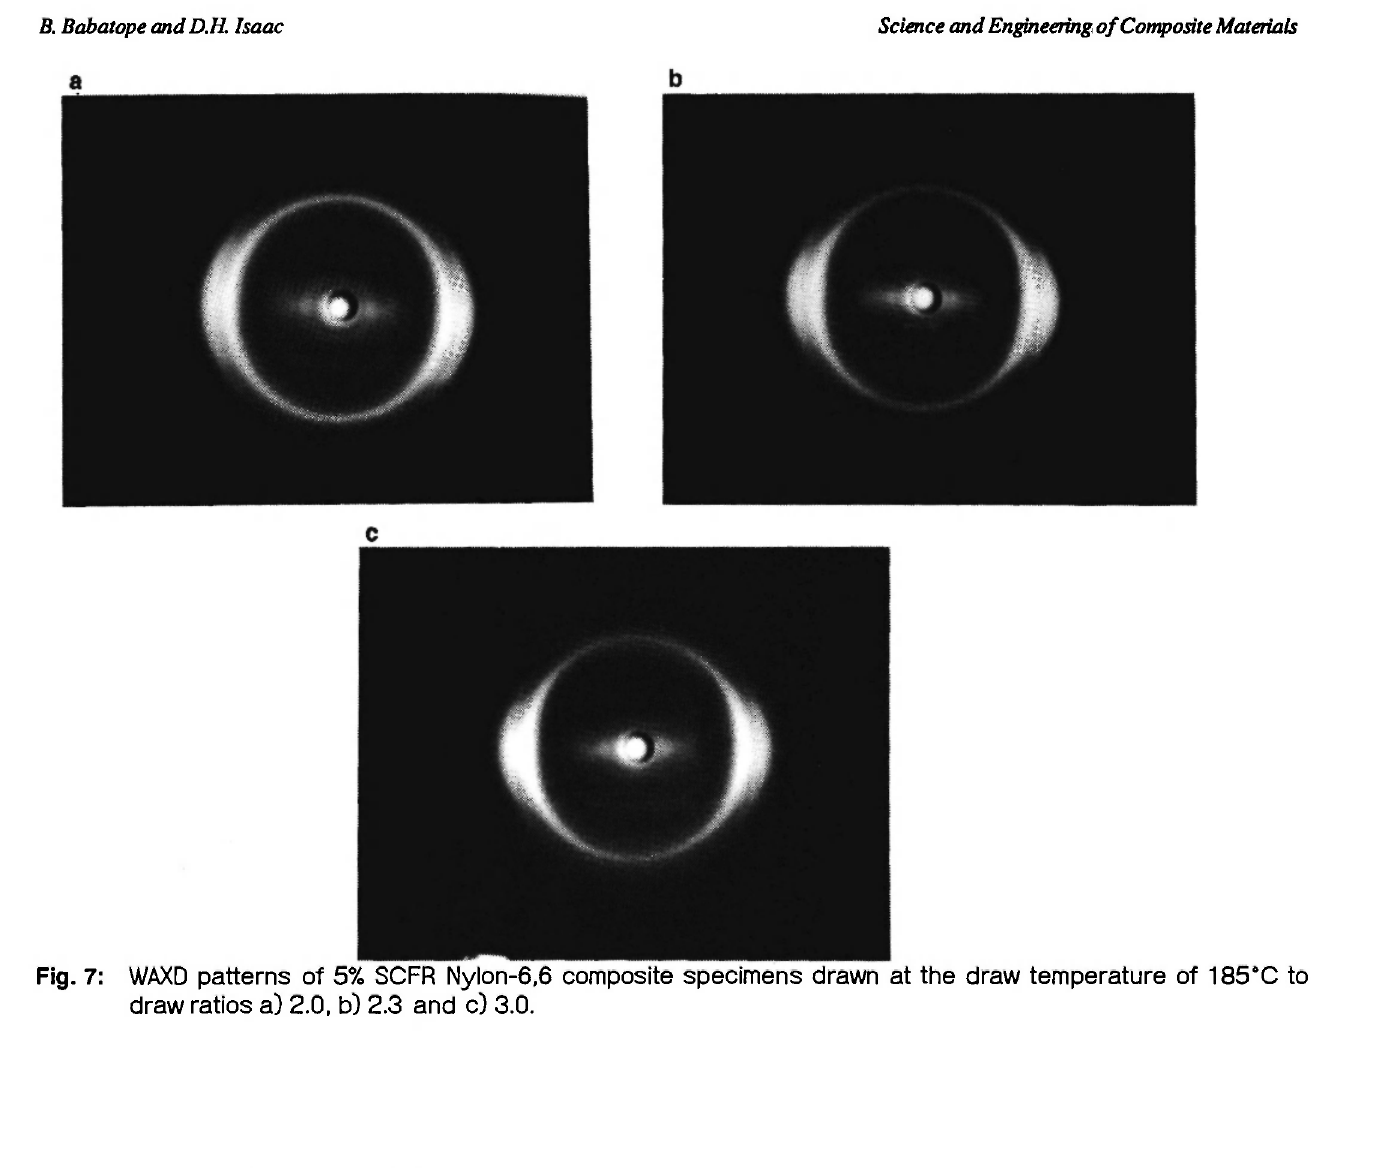
Fig. 7: WAXD patterns of 5% SCFR Nylon-6,6 composite specimens drawn at the draw temperature of 185°C to draw ratios a) 2.0, b) 2.3 and c)